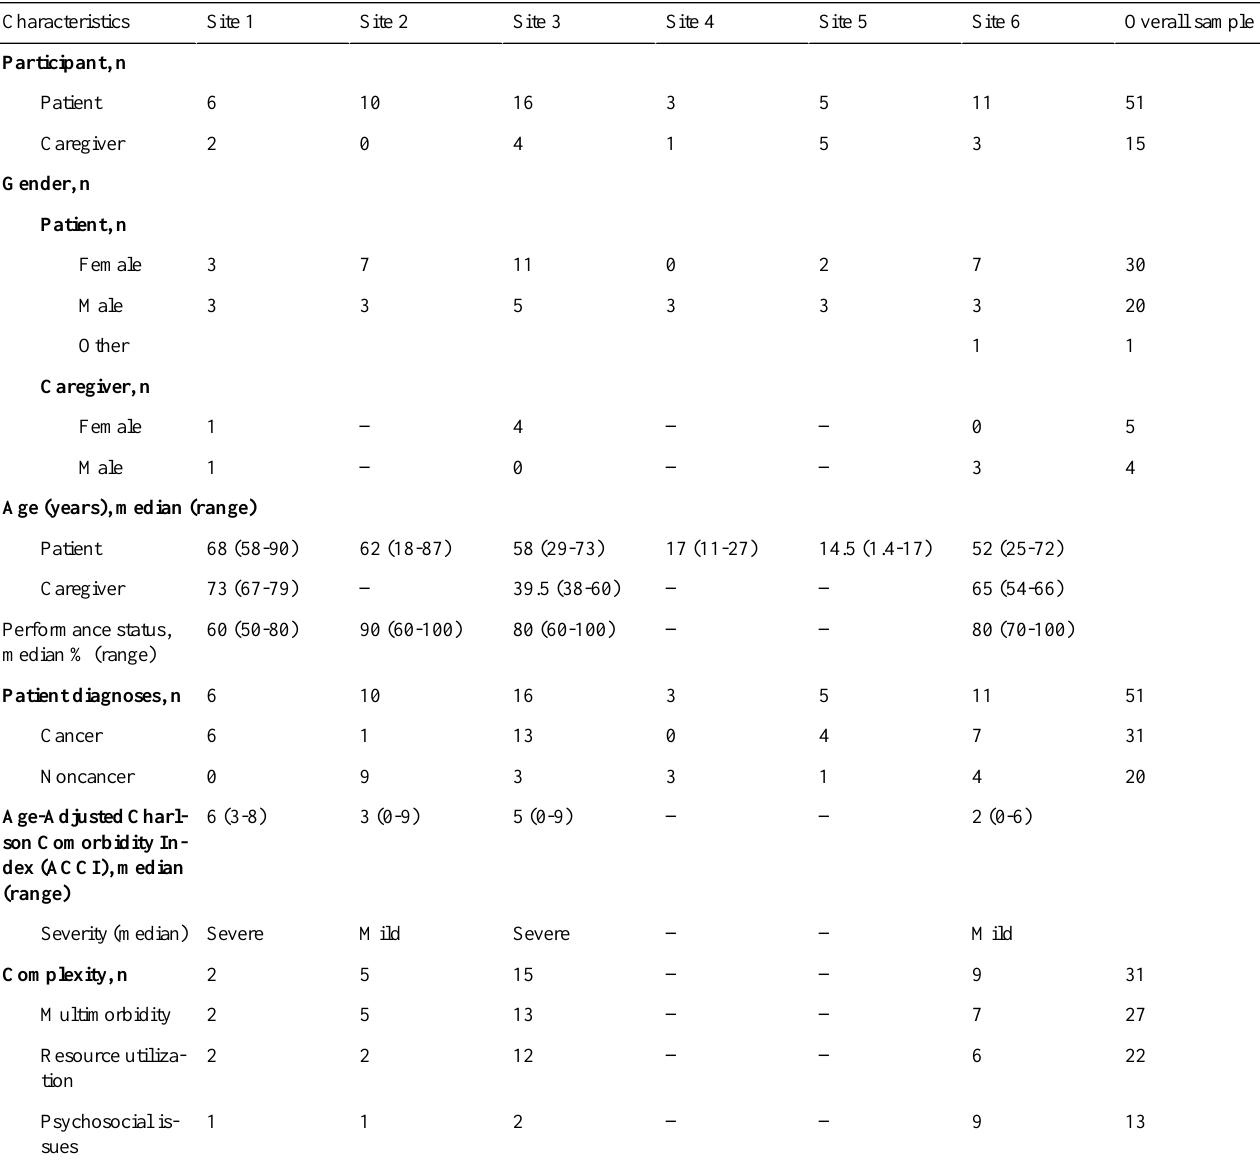
Table 2. Patient and caregiver